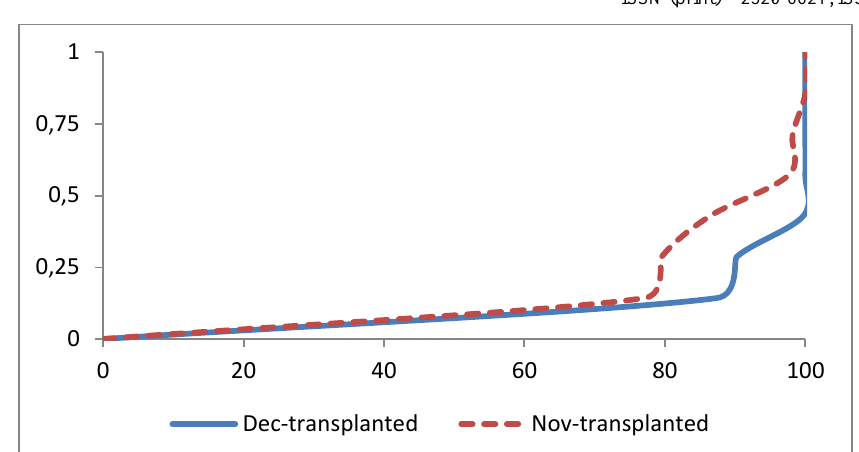
Figure 2. Cumulative Distribution Functions of Forecasted Rice Yields (in % of Potential Yield) for Two Transplantation